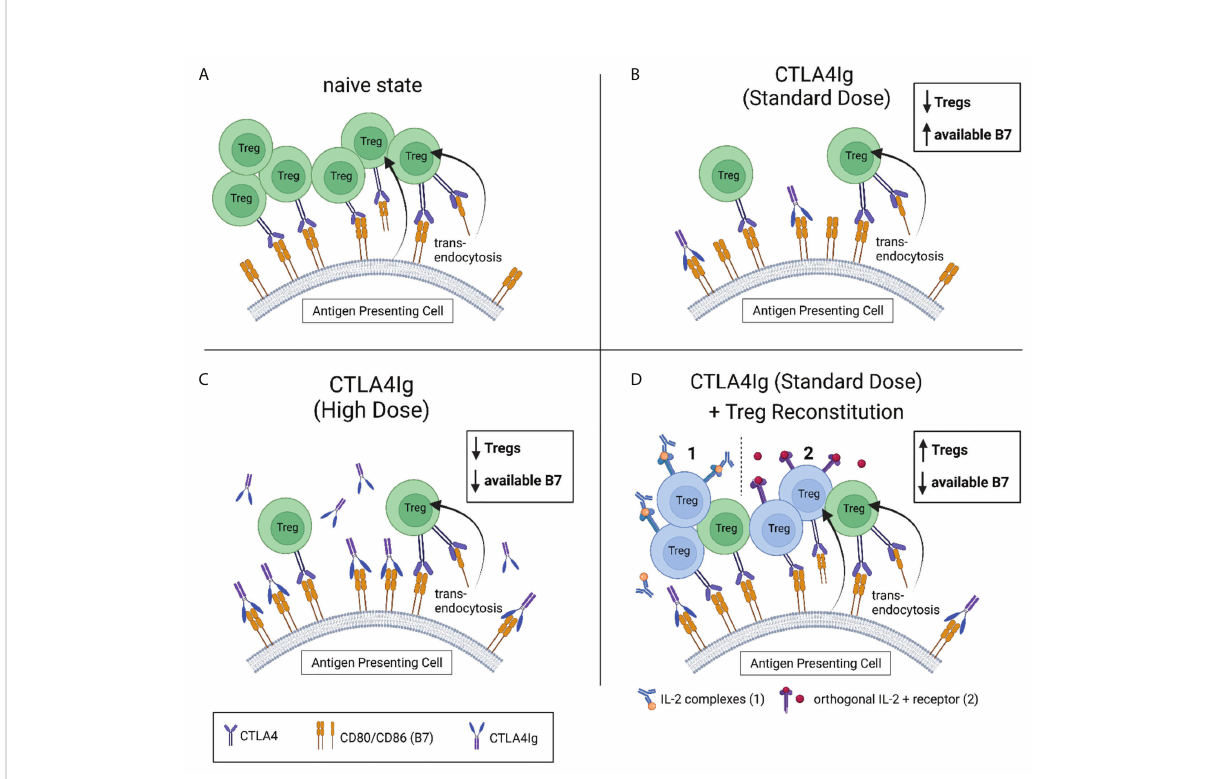
FIGURE 2 Strategies to compensate for reduced Treg levels under CTLA4Ig. (A) Tregs control the amount of available of CD80 and CD86 (B7) on antigen presenting cells (APC) through competitive inhibition and trans-endocytosis. (B) CTLA4Ig causes a dose-independent drop in Treg frequencies, contradicting their restriction on surface B7. Subsequently, more B7 is available for CD28-mediated co-stimulation. Standard doses of CTLA4Ig (10mg/kg) are not suf fi cient to bind all available B7. This can be compensated by administering higher doses of CTLA4Ig (50mg/kg) in the experimental setting (C) , or by reconstituting the recipient ’ s Treg levels (to or beyond naïve levels). Two promising strategies to reconstitute Tregs under costimulation blockade are depicted in (D) (1). Interleukin-2 complexed with an anti-IL-2 monoclonal antibody (IL-2 complexes) has been successfully used to selectively expand Tregs under costimulation blockade in vivo . (2) Engineered Tregs expressing a modi fi ed orthogonal IL-2 receptor that exclusively binds a modi fi ed ( orthogonal ) IL-2 have successfully been used for adoptive cell therapy in a mixed chimerism model. In both models, the re-established control of B7 expression on APCs by reconstituted Tregs has permitted suf fi cient immunosuppression with CTLA4Ig in standard